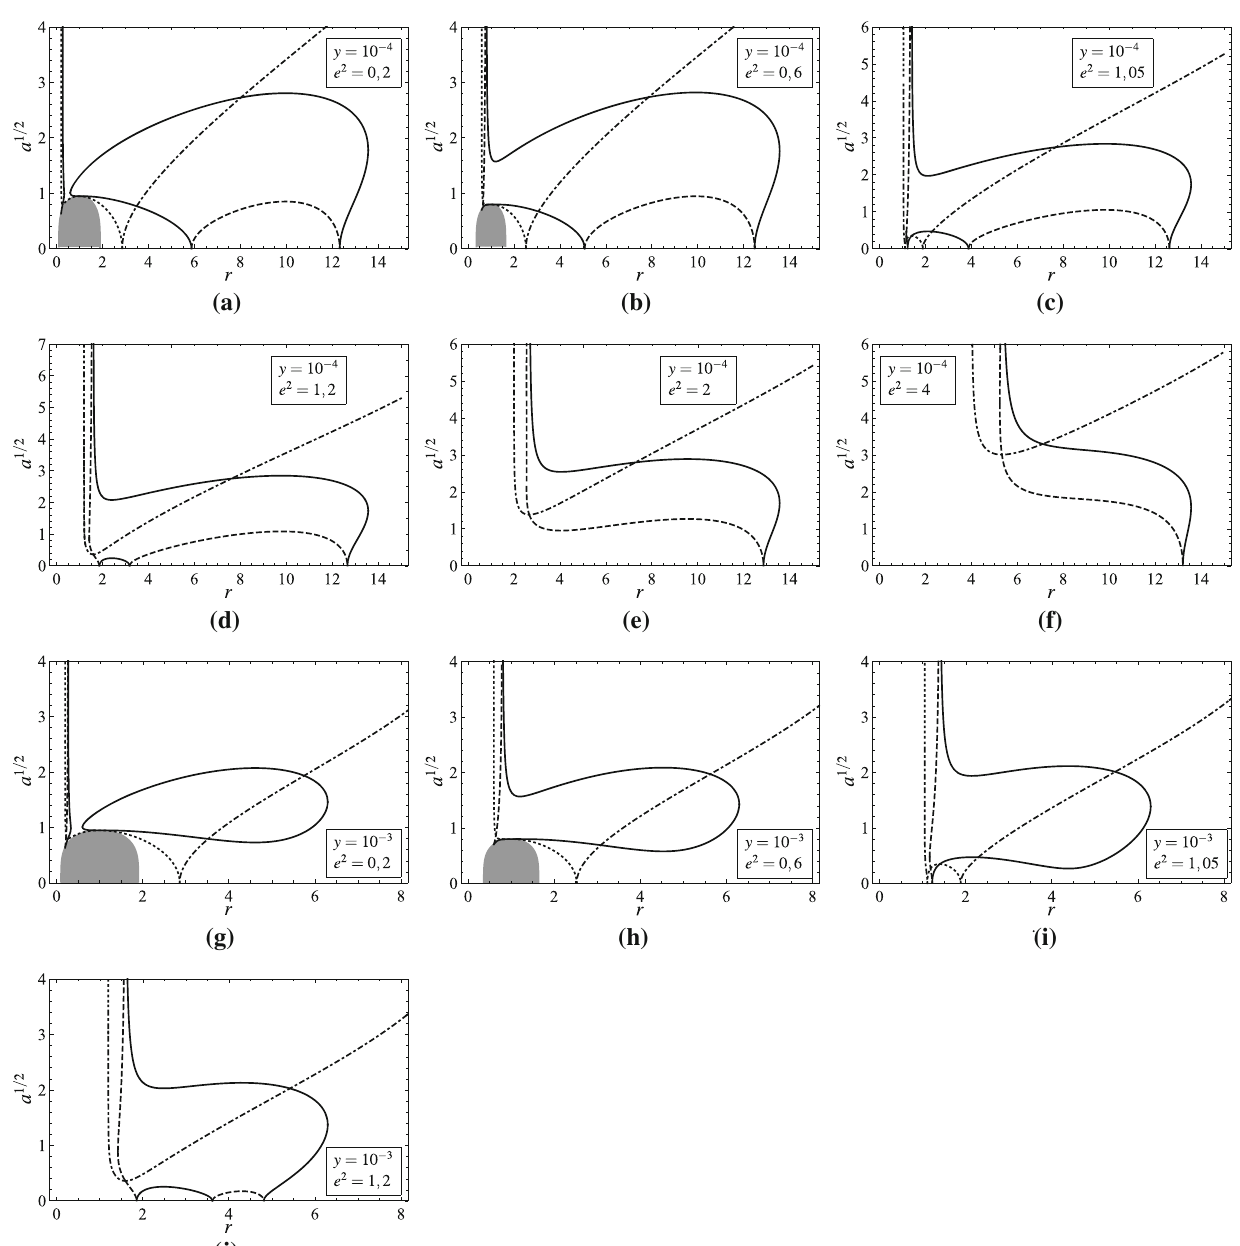
Fig. 7 Characteristic mutual positions of marginally stable and pho- ton orbits in dependence of the rotational parameter a for appropriately chosen KNdS spacetimes with cosmological parameter y and charge parameter e . Plus/minus-family marginally stable orbits are given by